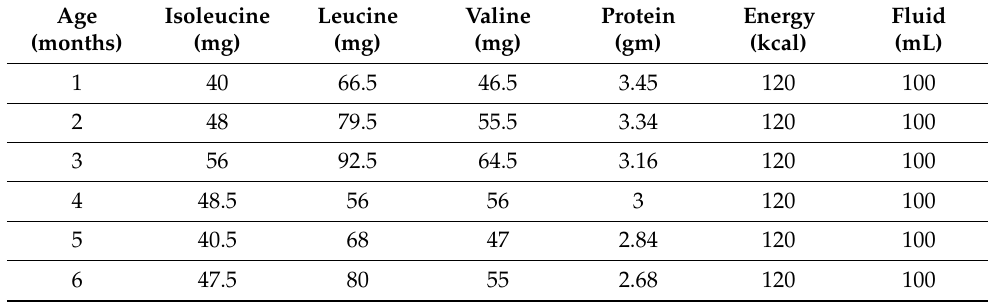
Table 1. Daily recommended intake of BCAAs, protein, and fluid for MSUD patients.